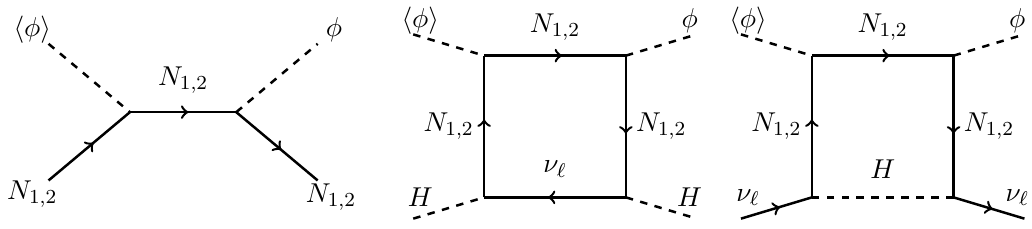
Figure 4 . Dominant Feynman diagrams for evaporation